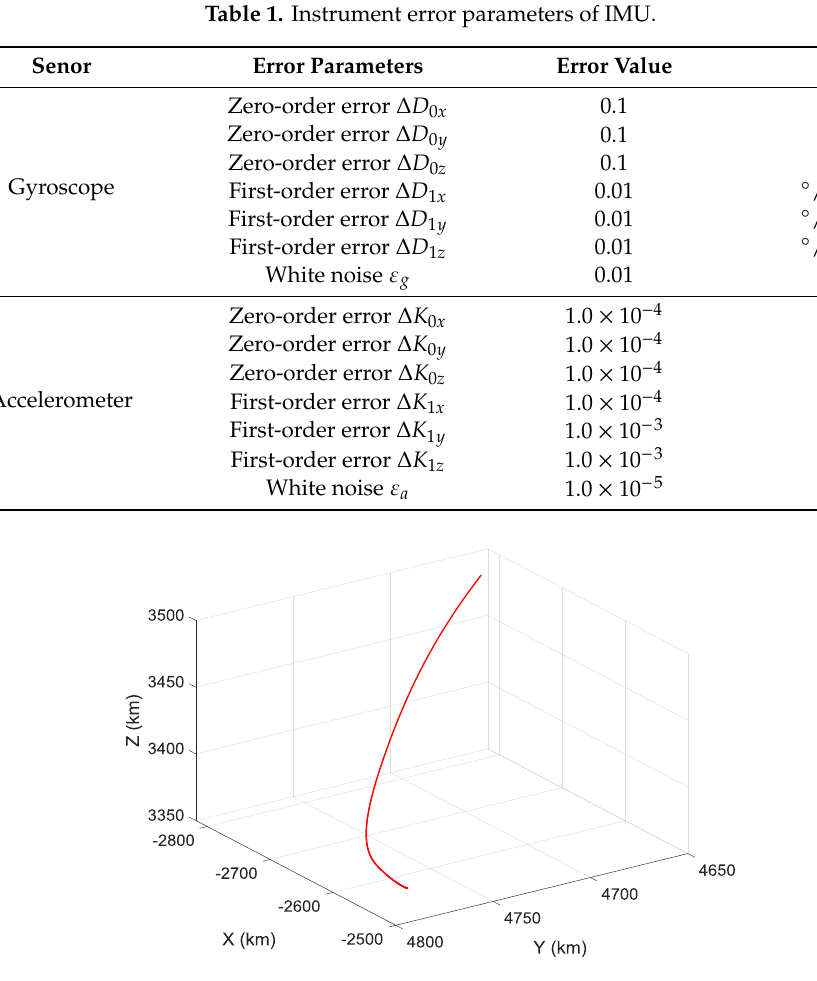
Figure 4. Standard flight path in geocentric coordinate.